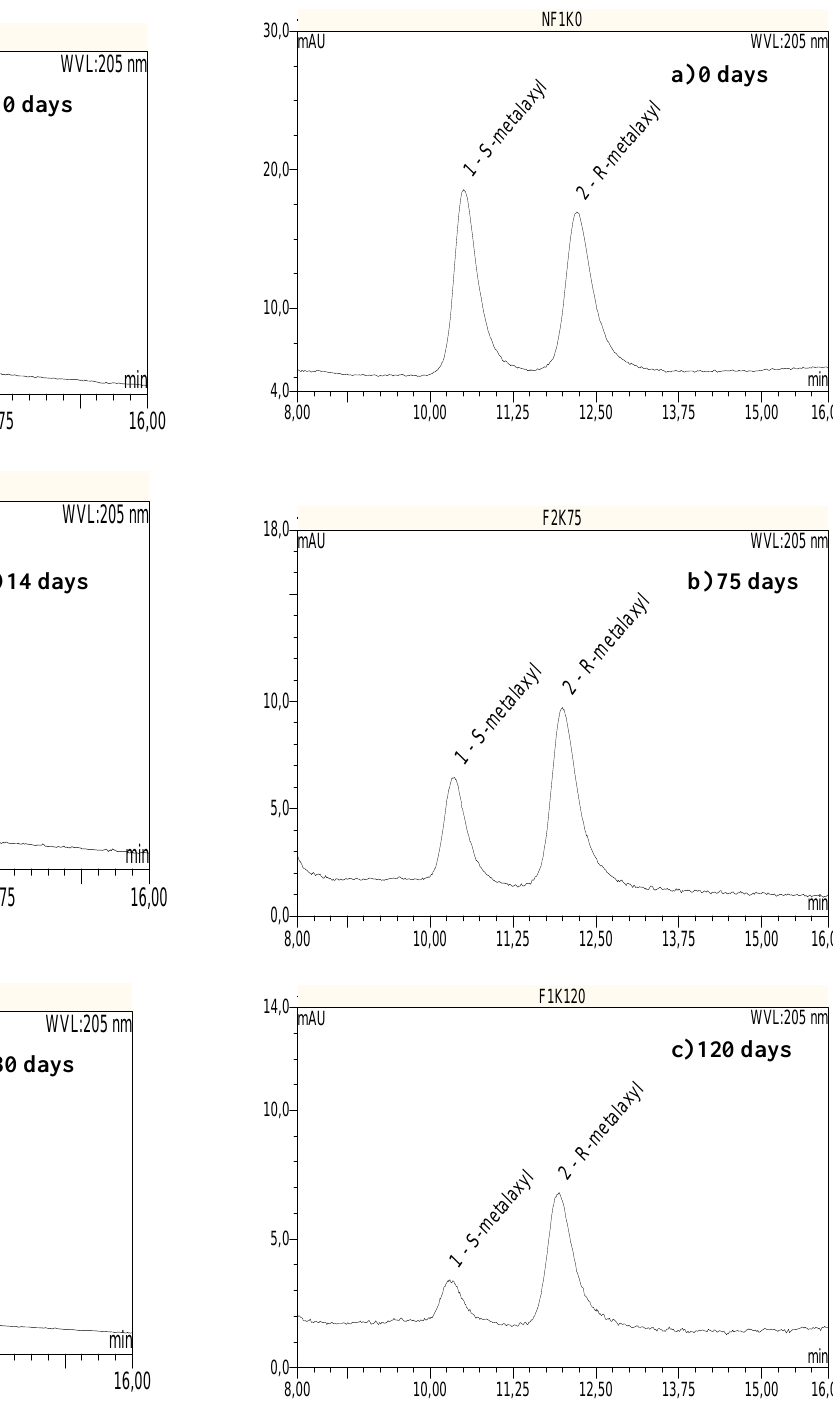
Figure 2: HPLC-DAD chromatograms showing elution of R and S-metalaxyl in the German soil after a) 0; b) 14; and c) 30 days of incubation.